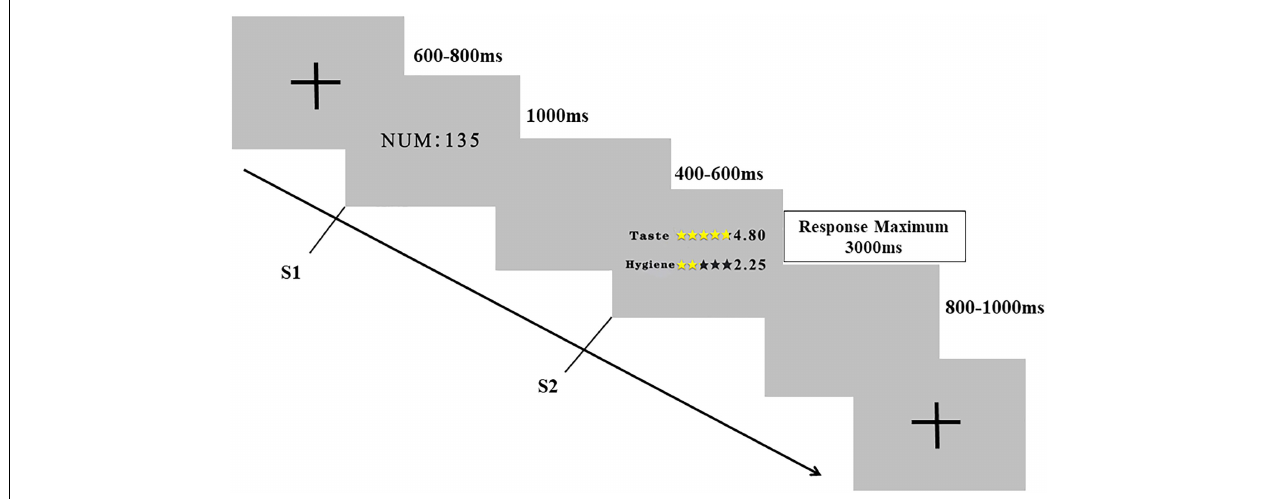
FIGURE 2 | Schematic illustration of one trial in the experimental task of Study 2. Participants were instructed to make a “choose” or “not choose” decision after the presentation of S2 along with taste and hygiene rating